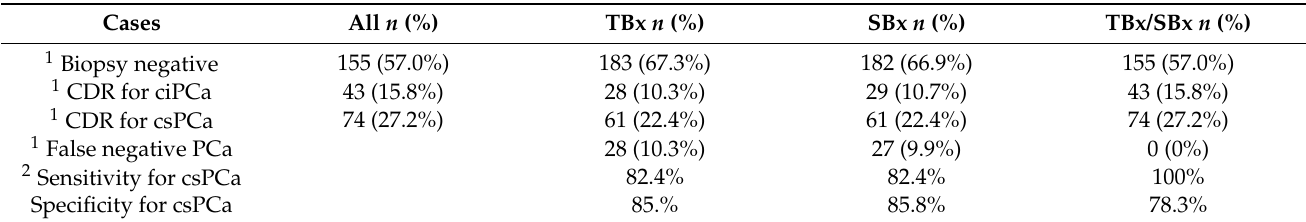
Table 3. Detection rate, diagnostic sensitivity, and specificity of TBx and SBx.